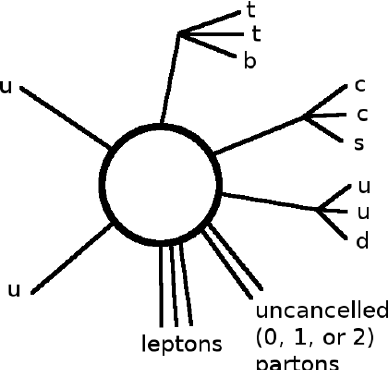
Figure 2 . An example of a sphaleron-like transition event starting from an initial state of two up quarks. The diagram is a representation of the event as written to the LHE (cid:12)le in order to allow correct determination of color (cid:13)ow by PYTHIA for decay and